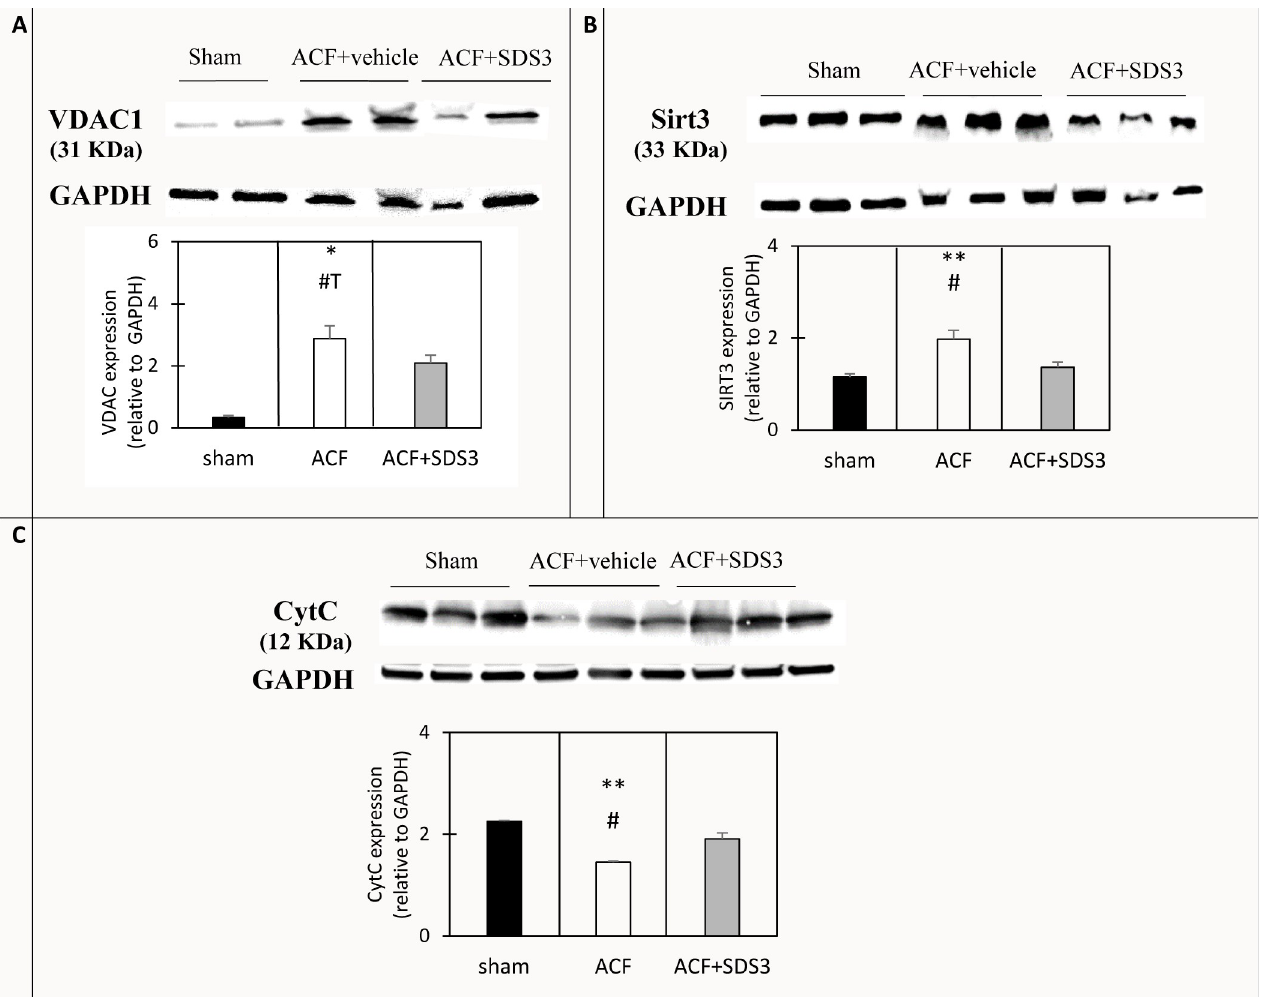
Fig 5. Representative Western blot analysis of mitochondrial proteins in LV tissue homogenate (B) and mitochondrial-fraction lysate (A, C). The lower panel displays quantification of the mitochondrial proteins. � P < 0.05, �� P < 0.01- relative to sham, # P < 0.05, #T = 0.05 < P < 0.1 relative to ACF+SDS3. n = 2–3 per